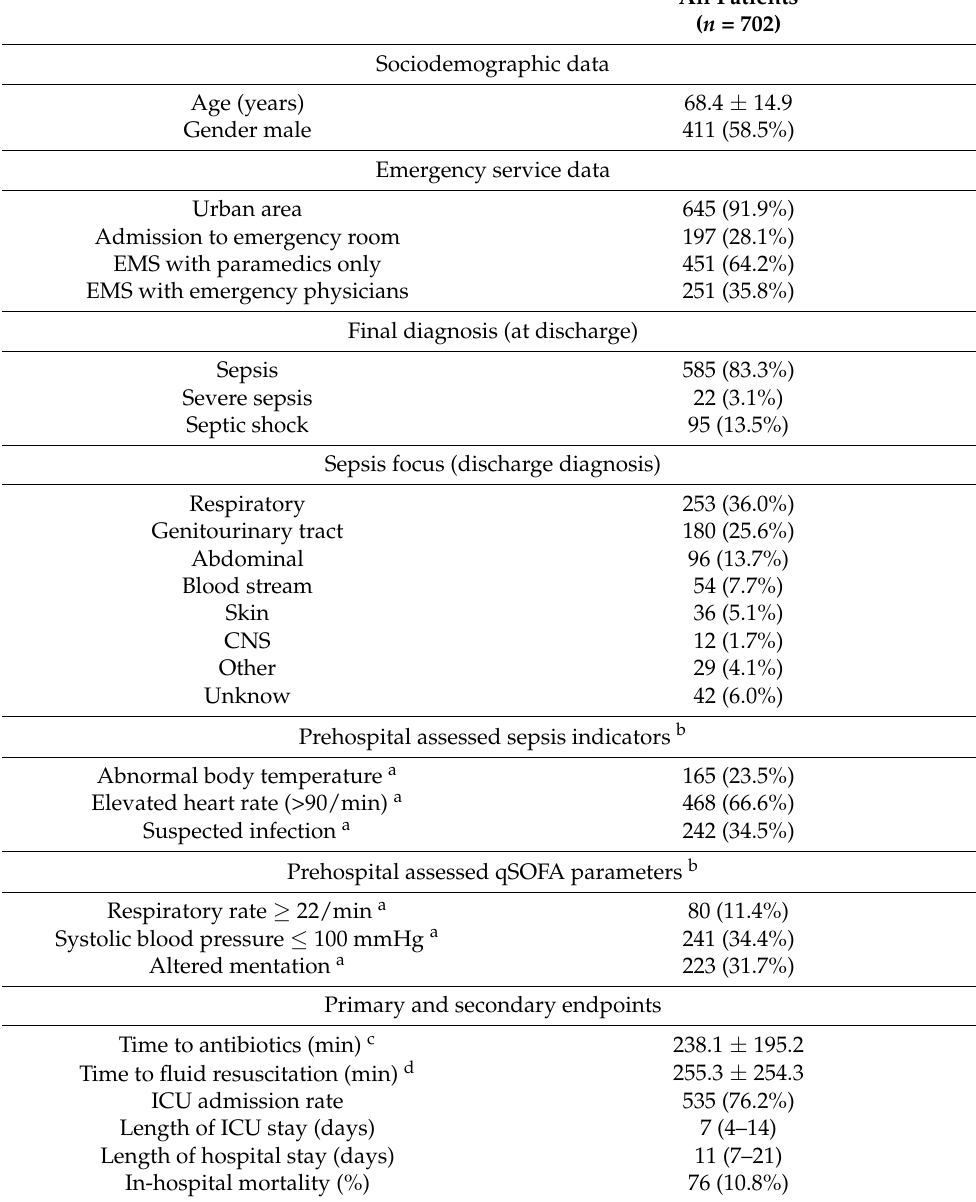
Table 1. Baseline characteristics, disease characteristics, sepsis indicators and outcome of the study